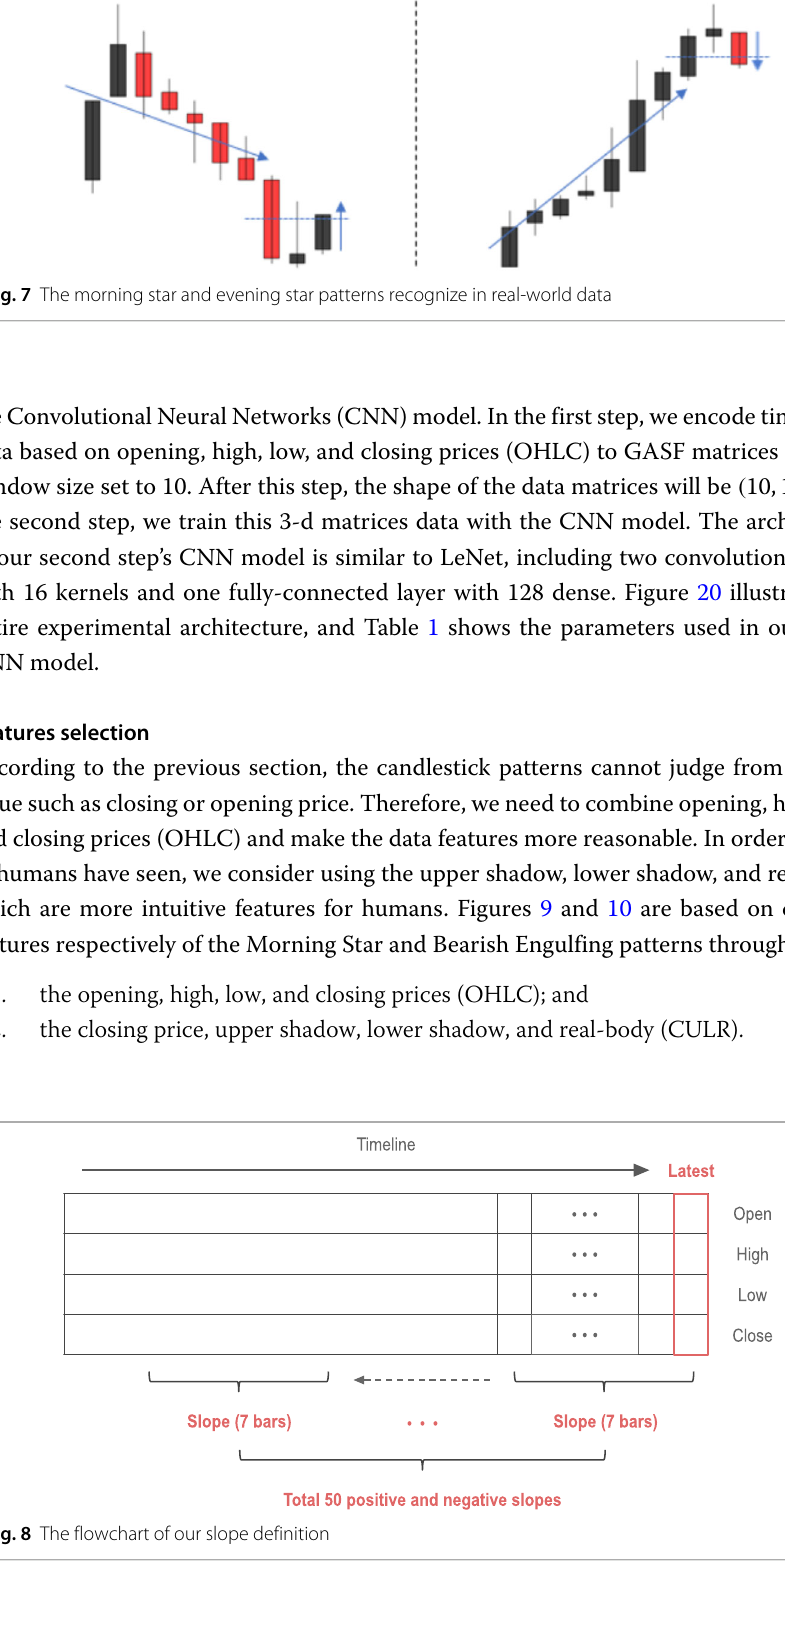
Fig. 7 The morning star and evening star patterns recognize in real-world data